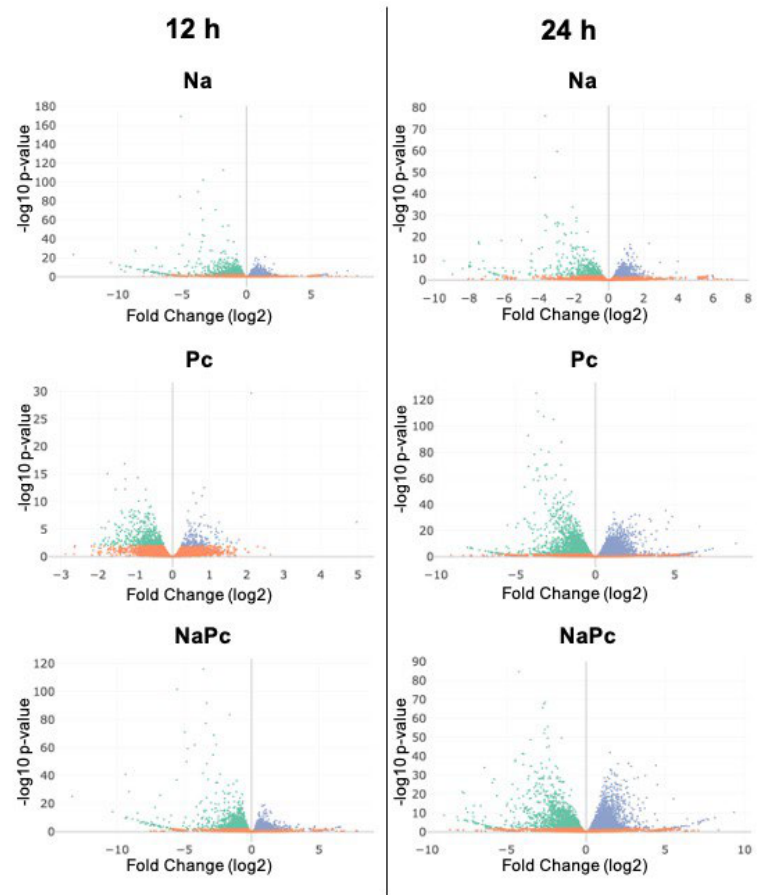
Figure 2. Differential gene expression of treatments with N. aberrans and Phytophthora capsici against control plants at 12 and 24 h. Na: Nacobbus aberrans treatment. Pc: Phytophthora capsici treatment. NaPc: Phytophthora capsici treatment after Nacobbus aberrans treatment. C: Control plants. Green: downregulated genes. Blue: upregulated genes. Orange: Mean genes. p < 0.01.